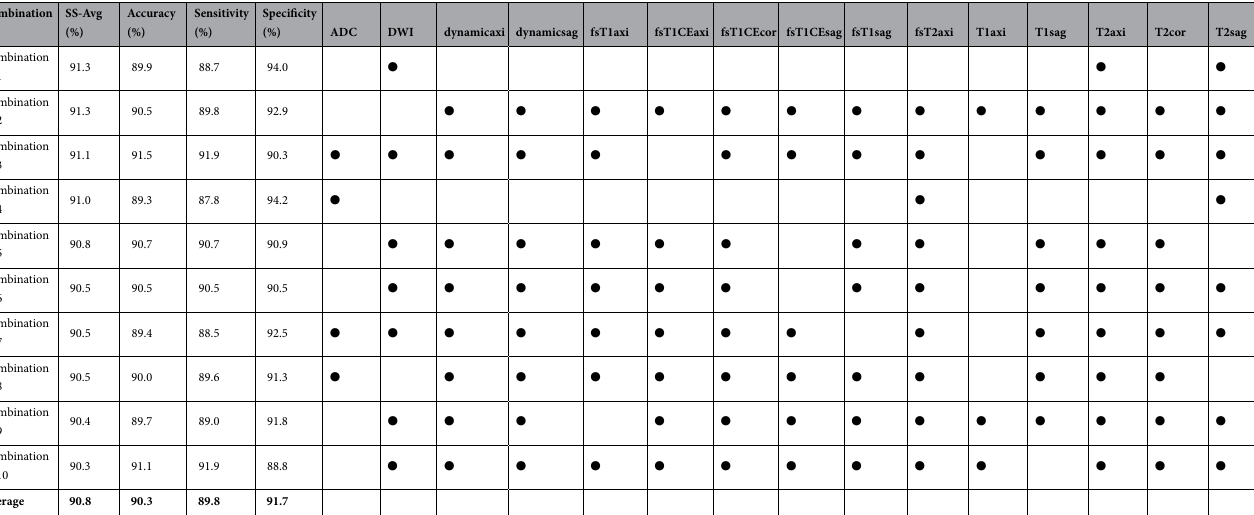
Table 1. Results of the DNN models for combinations of MRI sequences. The top 10 combinations of MRI sequences in terms of the SS-Avg (average of sensitivity and specificity) are shown. The average data for the top 10 combination sets were adopted as the results of the DNN models (accuracy: 90.3%; SS-Avg: 90.8%; sensitivity: 89.8%; specificity: 91.7%). Combination set 1 (T2axi, T2sag, and DWI) was the most accurate combination. DWI: diffusion-weighted